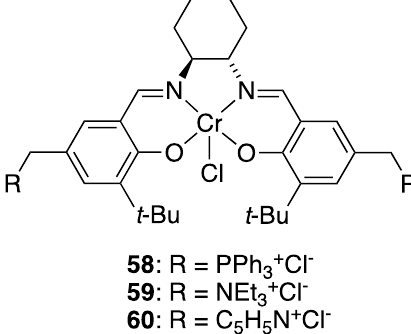
Figure 23. Cr–salen complexes with cationic side chains.